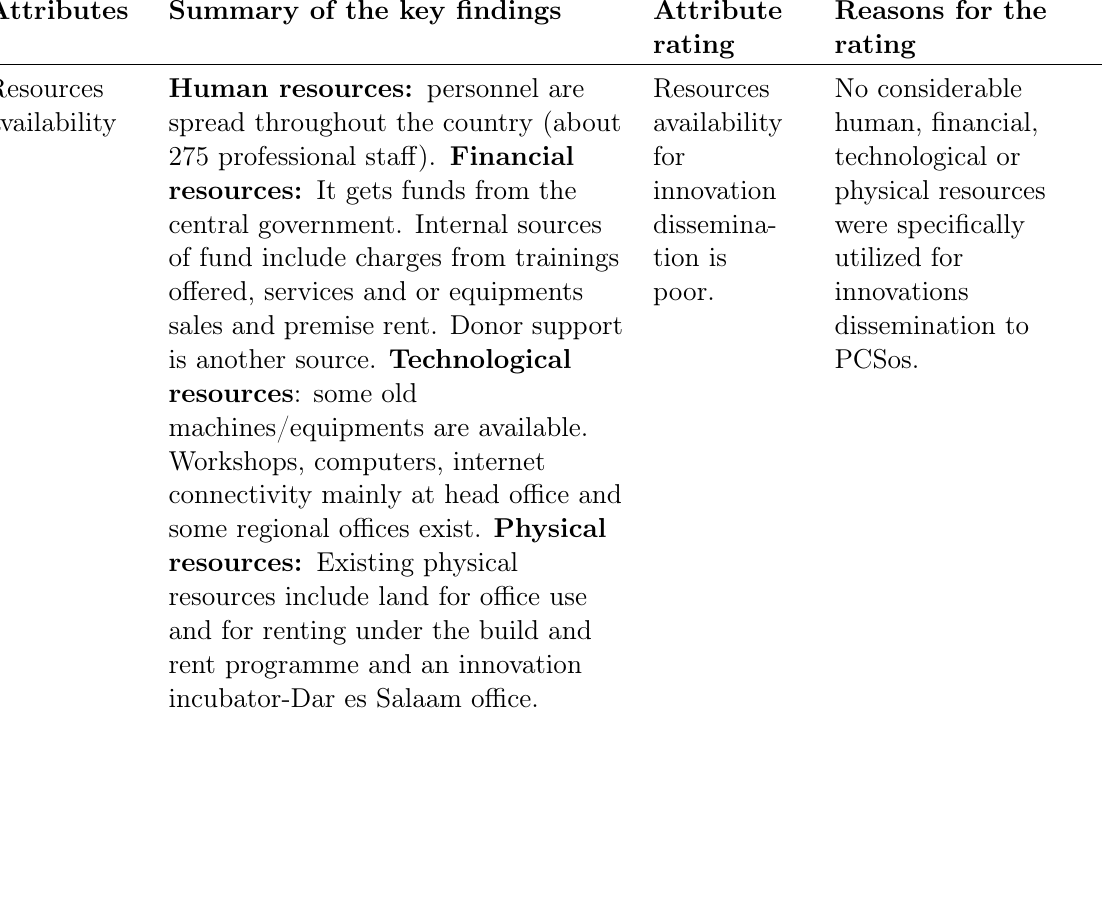
Table 4. SIDO resources capability attributes